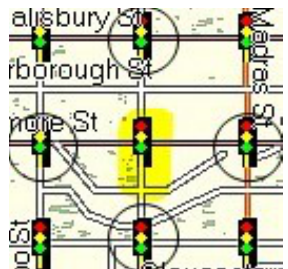
Fig.1 Highlighted traffic light under consideration is origin